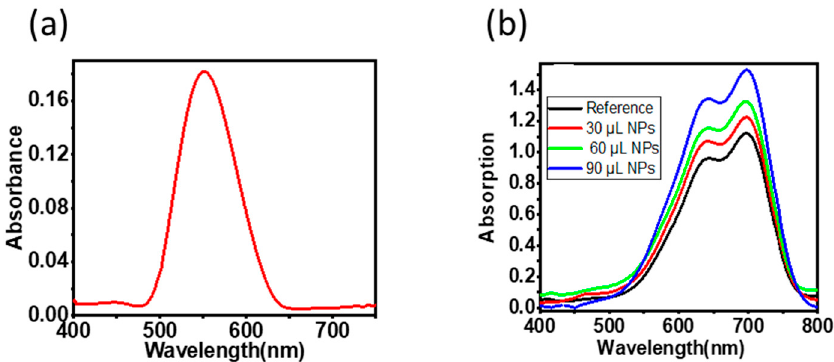
Figure 2. ( a ) The absorption spectrum of Au–Ag NPs solution; ( b ) the absorption spectra of ITO/PEDOT: PSS + Au–Ag/PTB7-Th: ITIC films as a function of the concentration of Au–Ag NP in the PEDOT: PSS.